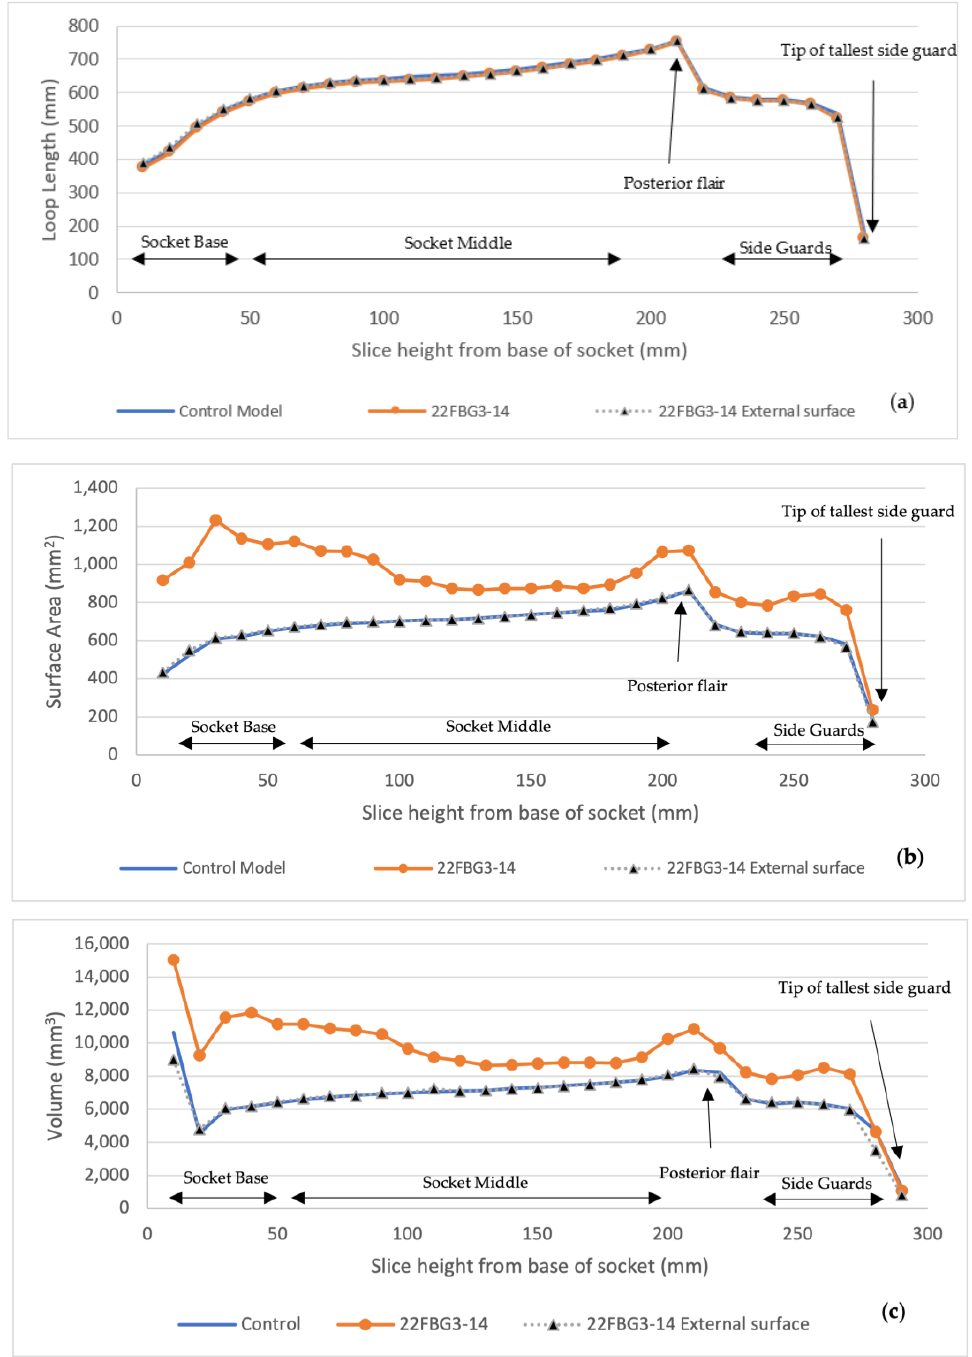
Figure 5. Analysis of scan model and reconstructed model vertical slices, compared to digital control model: ( a ) comparison of slice loop length based on external top edge; ( b ) comparison based on surface area of the top cut surface for each slice; ( c ) comparison of entire slice volume for each vertical height from socket base.